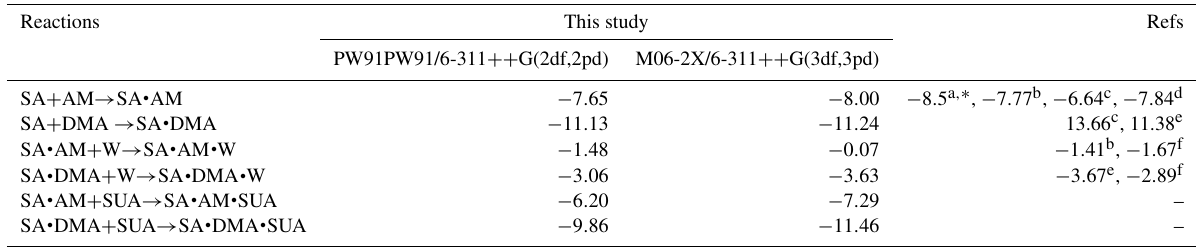
Table 1. Theoretical and experimental values of the free energy change for several basic reactions in kilocalories per mole. Reactions This